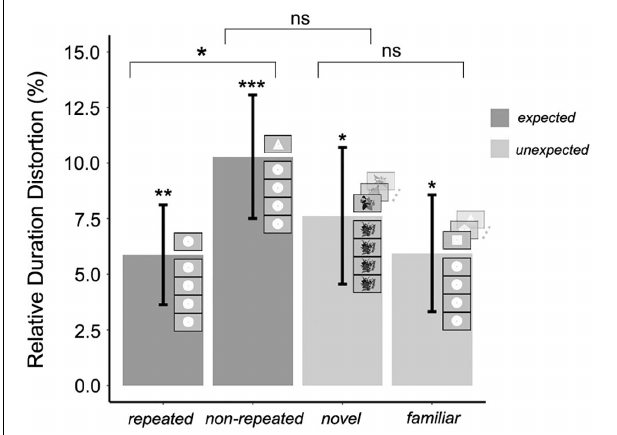
FIGURE 3 | Mean relative duration distortion for expected and unexpected target stimulus conditions in Experiment 1; error bars represent the standard error of the mean. The significance of the magnitude of the oddball effect in each experimental condition (Bonferroni correction for multiple one-tailed t -tests was used; p -value was significant if p < 0.01) and the significance of the three orthogonal planned contrasts (no need for p -value correction; p -value was significant if p < 0.05) between and within expected and unexpected target stimulus conditions is shown ( ∗ p < 0.05; ∗∗ p < 0.01; ∗∗∗ p <